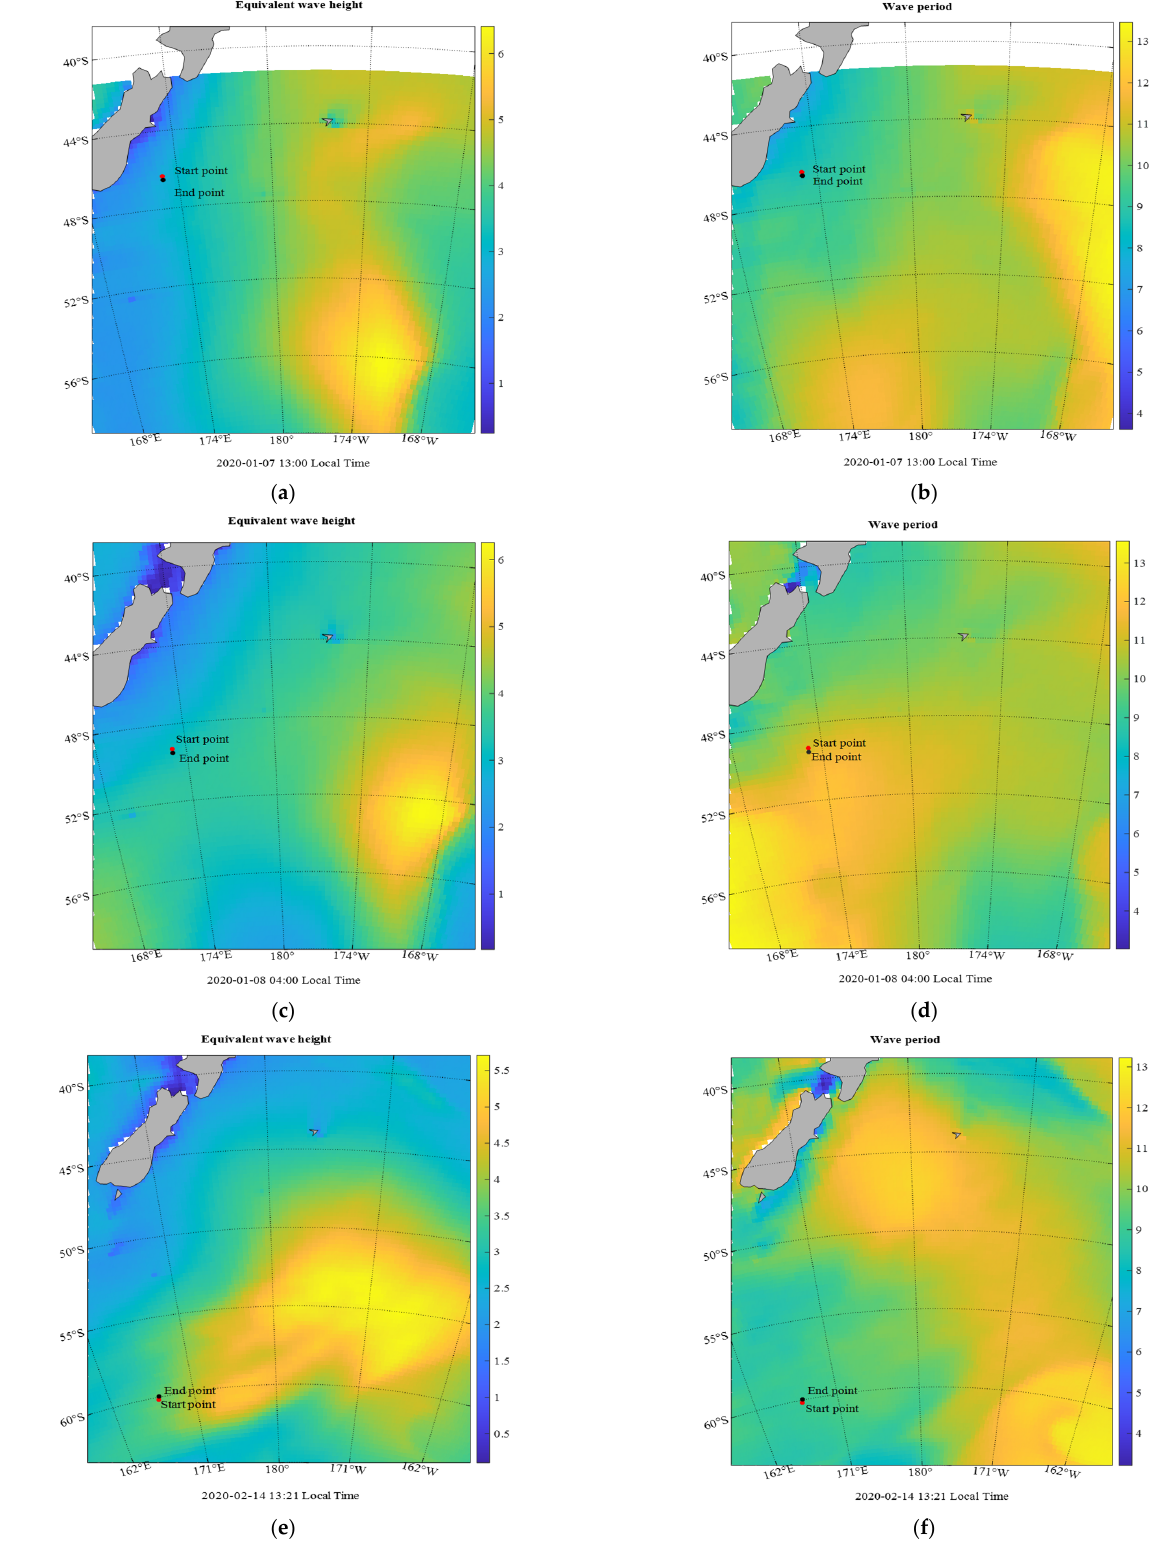
Figure 5. Weather forecast data: ( a ) equivalent wave height—7 January 2020; ( b ) wave period—7 January 2020; ( c )